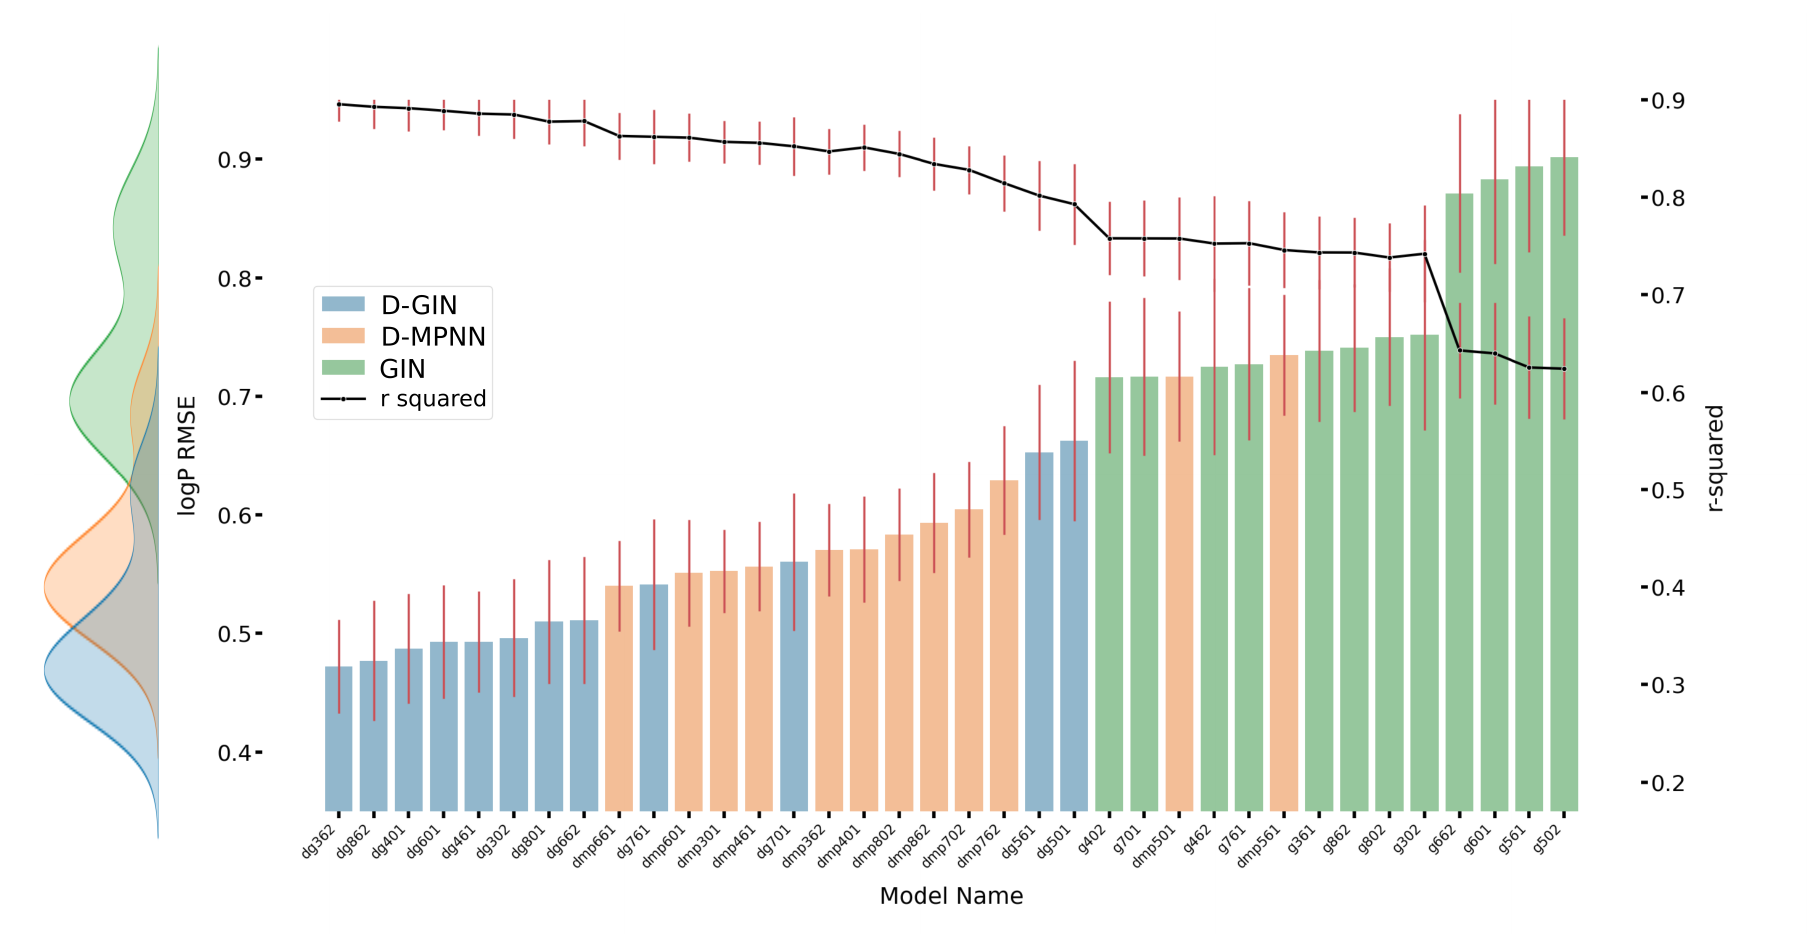
Figure A2. The first y-axis specifies the logP RMSE and the secondary x-axis the corresponding r 2 values for each GNN model. The D-GIN is colored blue, the D-MPNN orange and the GIN green. Each of the boxes represents one different model run. The kernel density of each model is shown on the very left side. The red lines correspond to the 95% confidence intervals. The model names are a combination of model type (D-GIN, GIN, D-MPNN), training approach and featurization type-a detailed description of each model name can be found in Tables A8–A19 in the Appendix